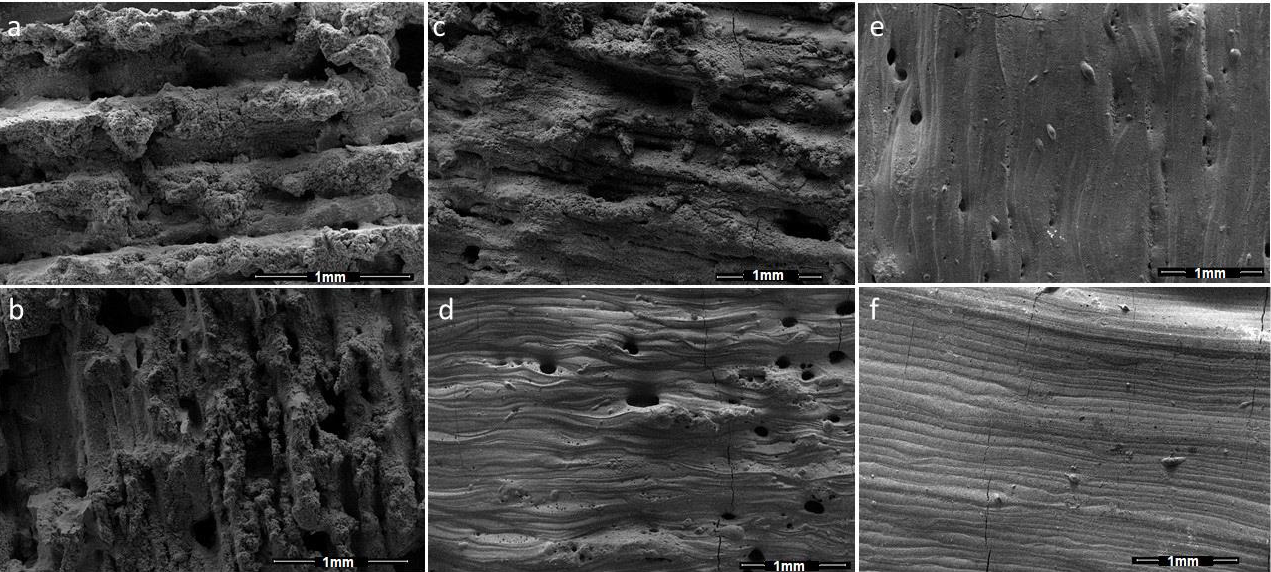
Figure 7. ( a ) Al 2 O 3 wt % 95, SiC wt % 5 at 120 W laser power. ( b ) Al 2 O 3 wt % 95, SiC wt % 5 at 150 W. ( c ) Al 2 O 3 wt % 95, SiC wt % 5 at 180 W. ( d ) Al 2 O 3 wt % 98, SiC wt % 2 at 120 W. ( e ) Al 2 O 3 wt % 98, SiC wt % 2 at 150 W. ( f ) Al 2 O 3 wt % 98, SiC wt % 2 at 180 W.